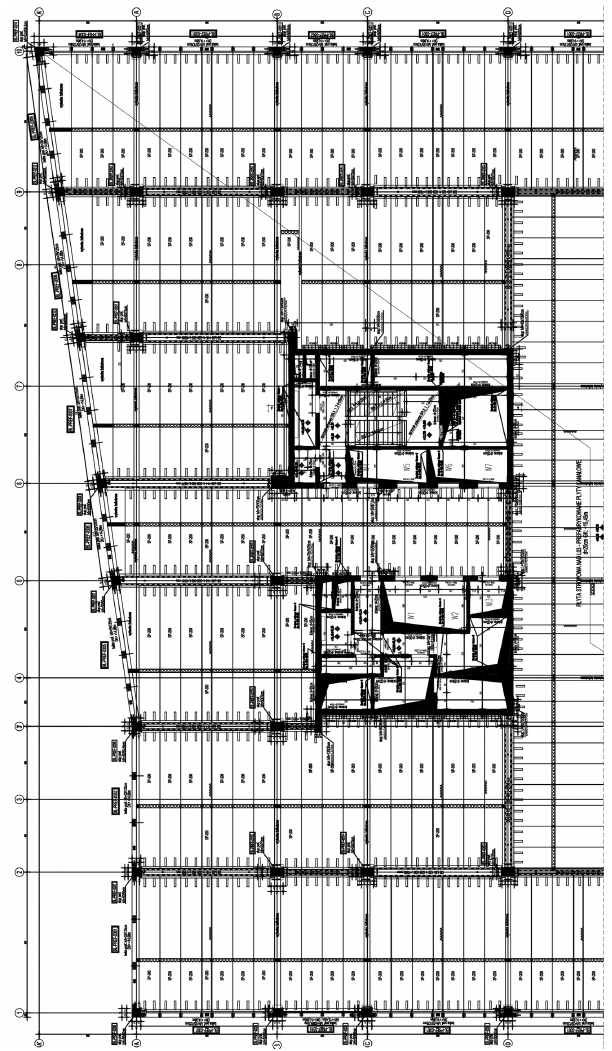
Figure 3. The Green2Day building slabs’ layout—Part 1. The design drawing was obtained from Grupa Projektowa Konstruktor Ltd.